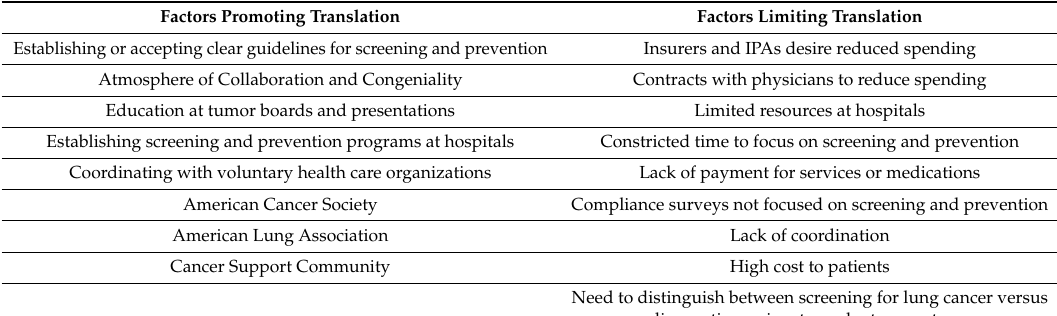
Table 2. Factors in Translating Screening and Prevention Science from Academic Centers to A ffi liated Network Community Centers and Collaborating Community